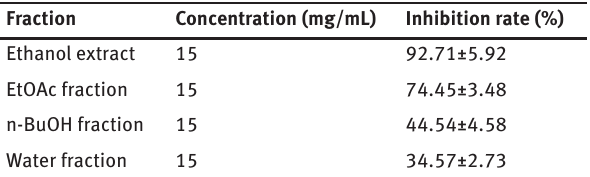
Table 1: Inhibitory effects of different fractions of ethanol extract from Lycopus lucidus on FXa.